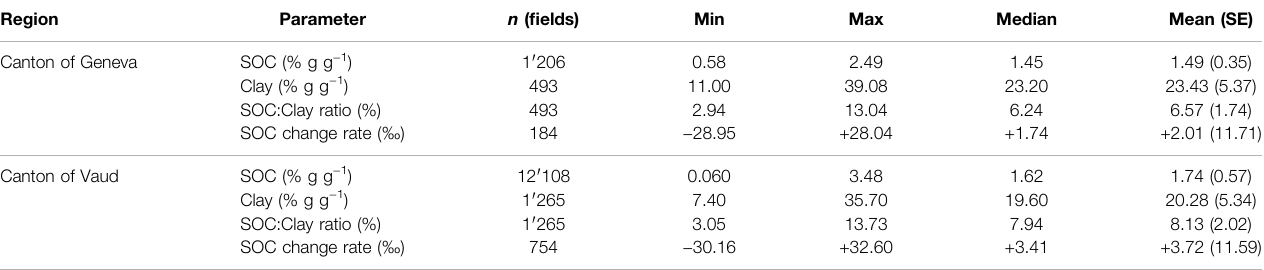
TABLE 1 | Distribution of soil organic carbon (SOC) (%), clay (%), SOC to clay ratio (%), SOC:Clay ratio (%) and annual SOC change rates ( ‰ ) for Geneva and Vaud croplands. Region